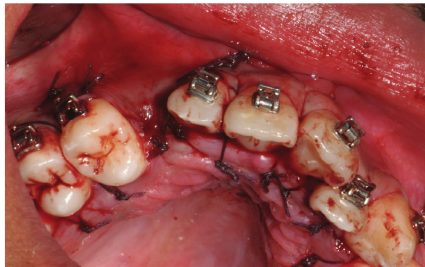
Figure 8: The flap repositioned and sutured.